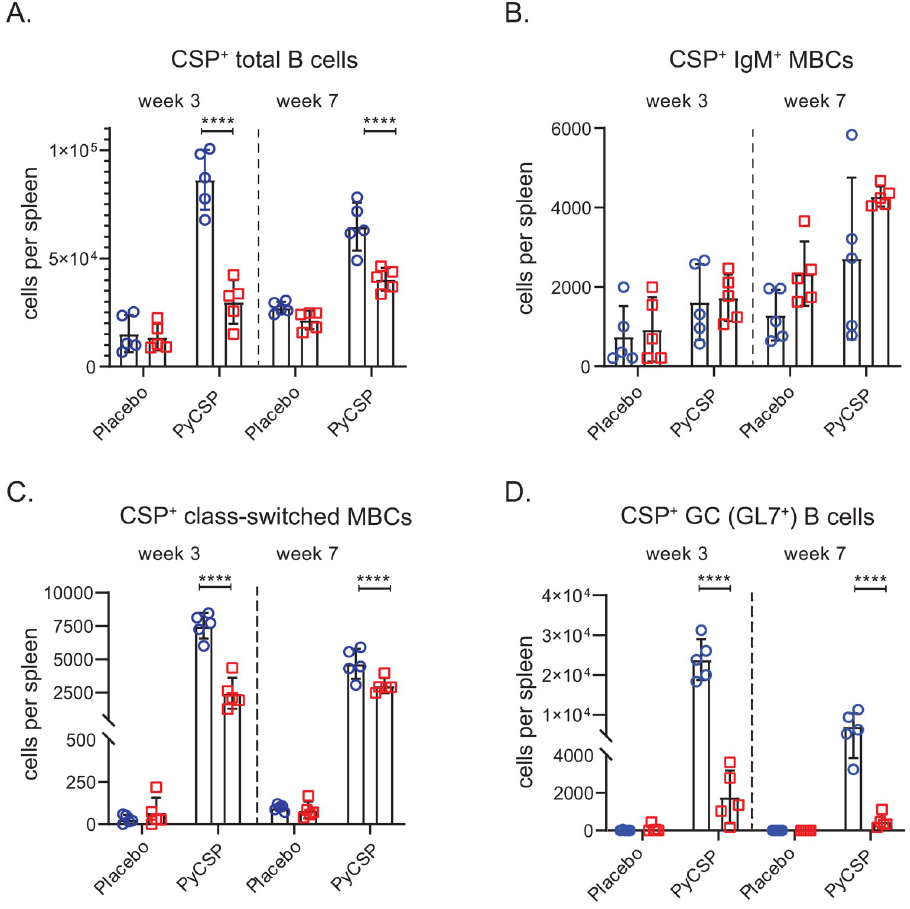
Fig 4. Py CSP-specific B-cell responses of BALB/cJ and C57BL/6J mice at weeks 3 and 7. 6–8 weeks old female BALB/cJ (n = 5) and C57BL/6J (n = 5) mice were immunized intramuscularly with 20 μ g of Py CSP adjuvanted with 20% adjuplex on weeks 0, 2 (Week 3) or weeks 0, 2 and 6 (week 7) and the splenocytes were isolated either on week 3 or week 7 as described in the materials and methods. Cartoon representing the general workflow in B-cell population analysis is illustrated (S5 Fig). B-cells responses of different B-cell populations per spleen were quantified for Py CSP- specific B-cells (A) , IgM memory B-cells (MBCs) (B) , class-switched (sw) Ig+MBCs (C) , and Germinal center (GC) B- cells (D ) in immunized and control BALB/cJ (blue circles) and C57BL/6J (red squares) mice. Data analyzed by Two- way ANOVA and p values were obtained by Tukey’s multiple comparison test. ���� p < 0 . 0001